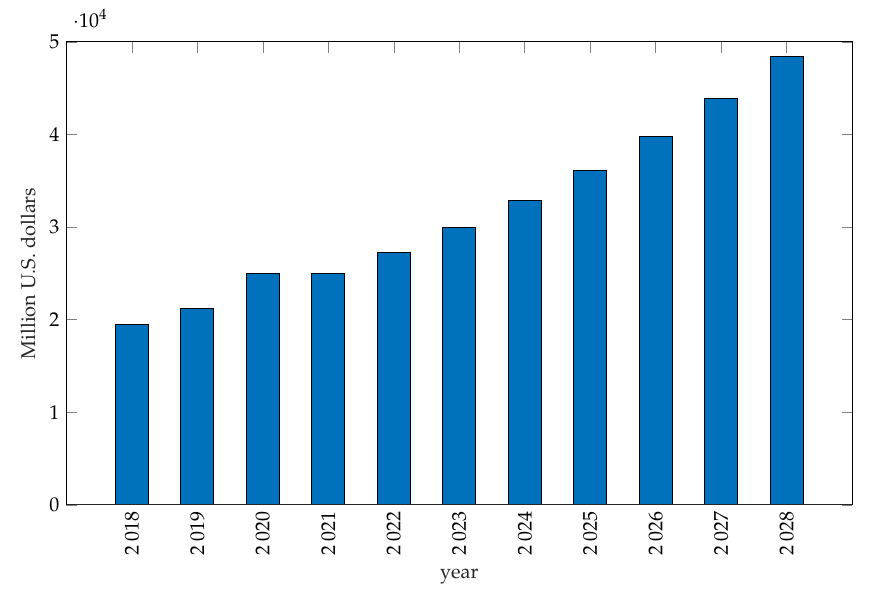
Figure 1. Projections for the global electric bike market between 2018 and 2028